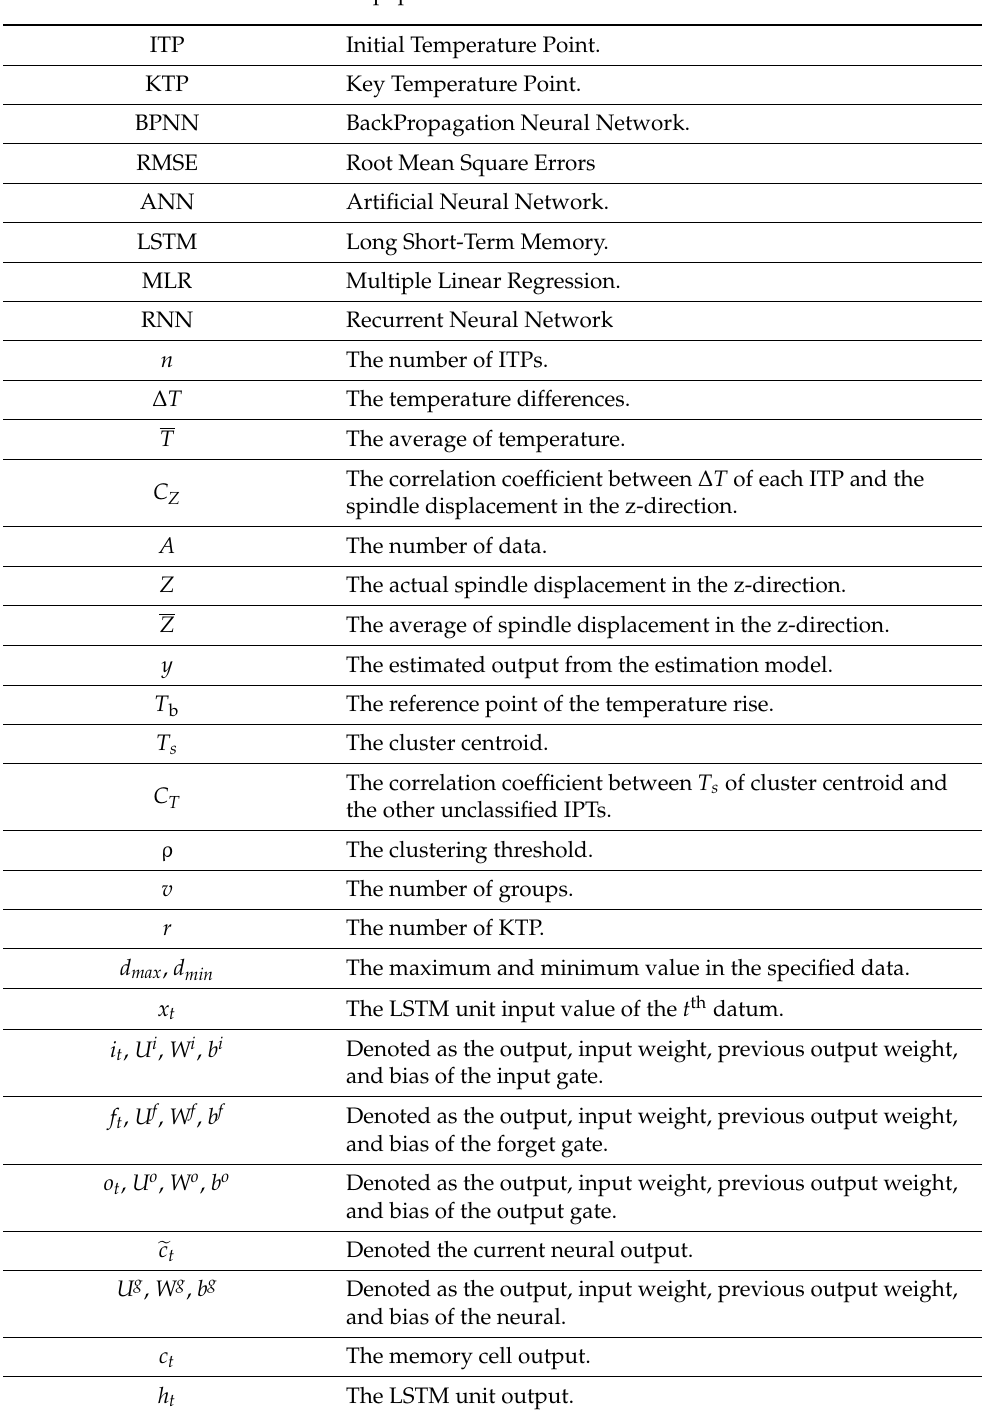
Table A1. Nomenclature used in this